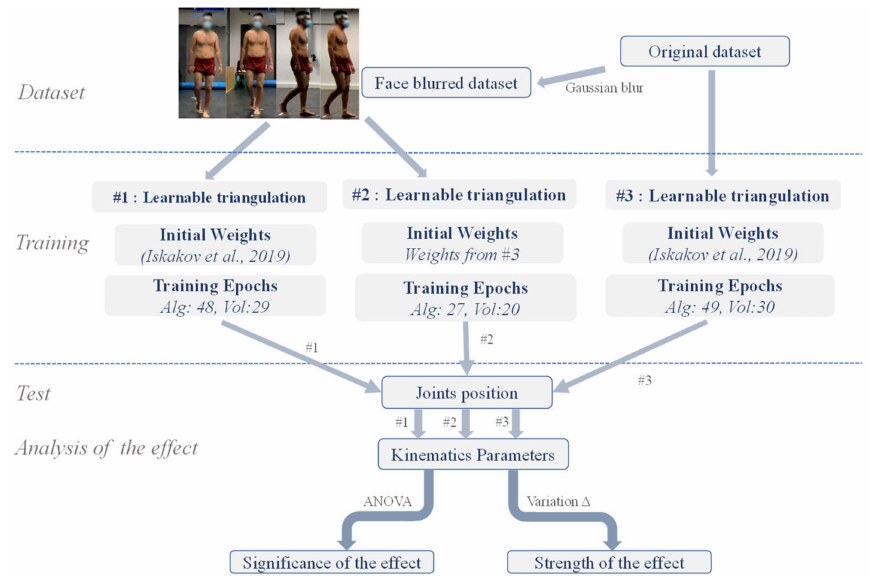
Figure 1. Flowchart of this study.